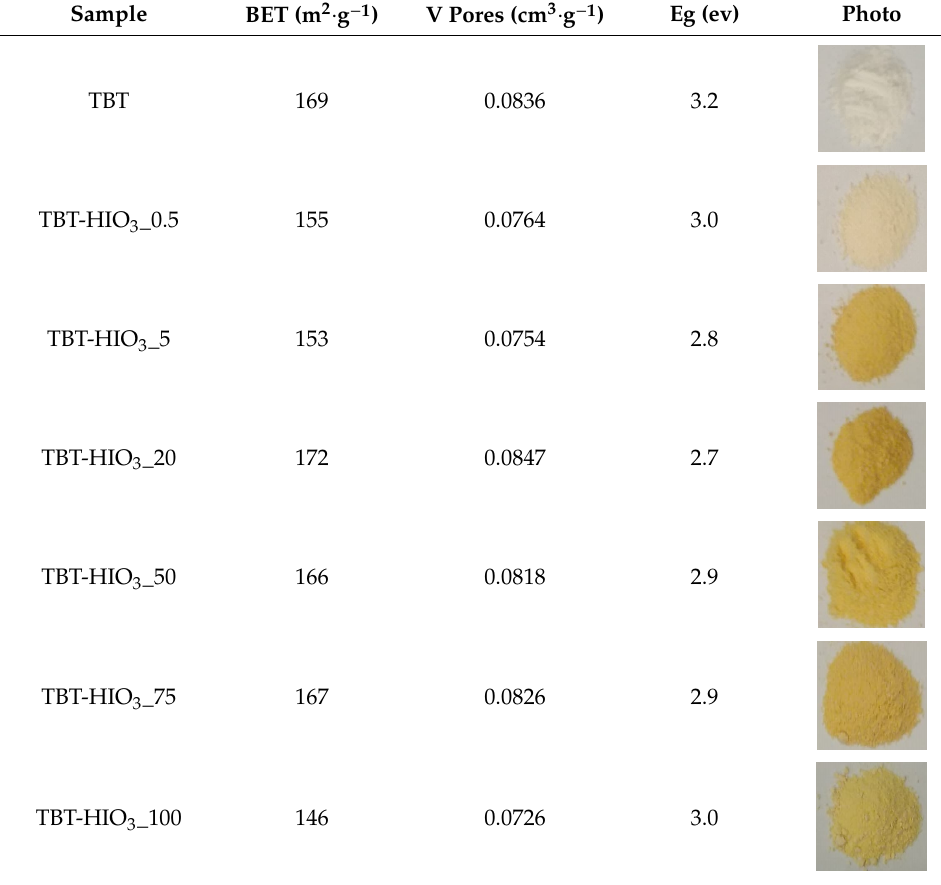
Table 4. Physicochemical characteristic of the obtained defective TiO 2 -HIO 3 samples.